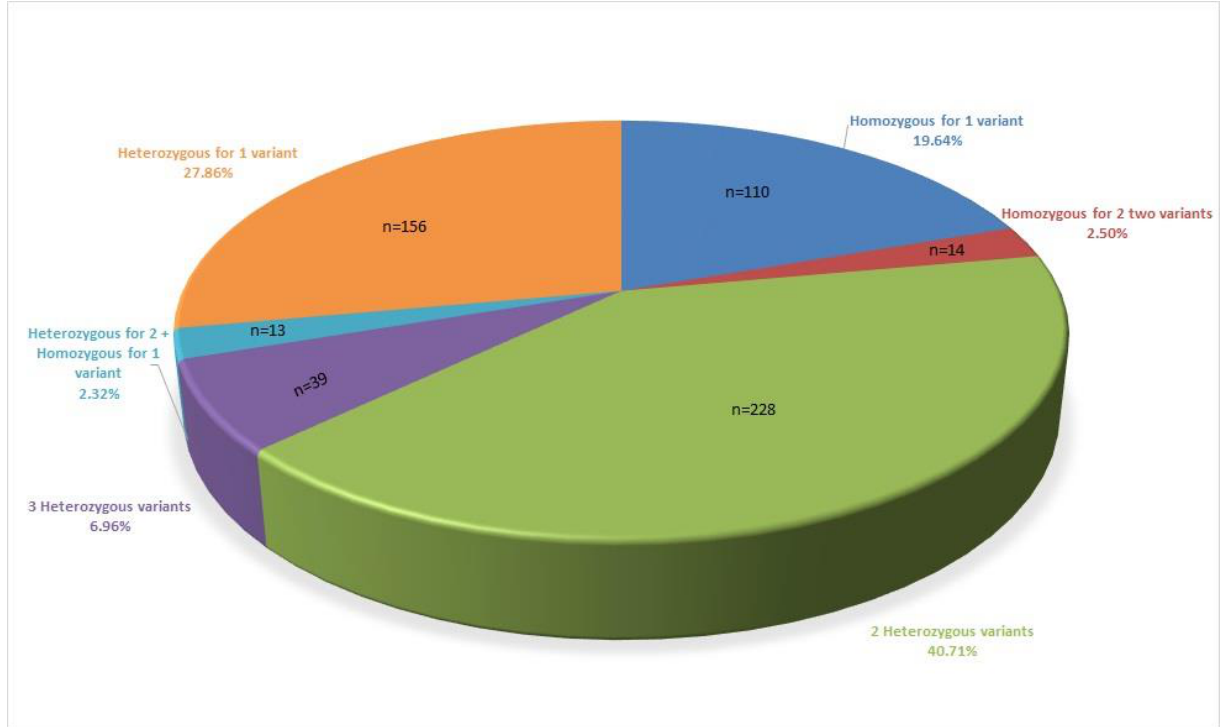
Figure 1. Distribution of patients according to mutation burden.